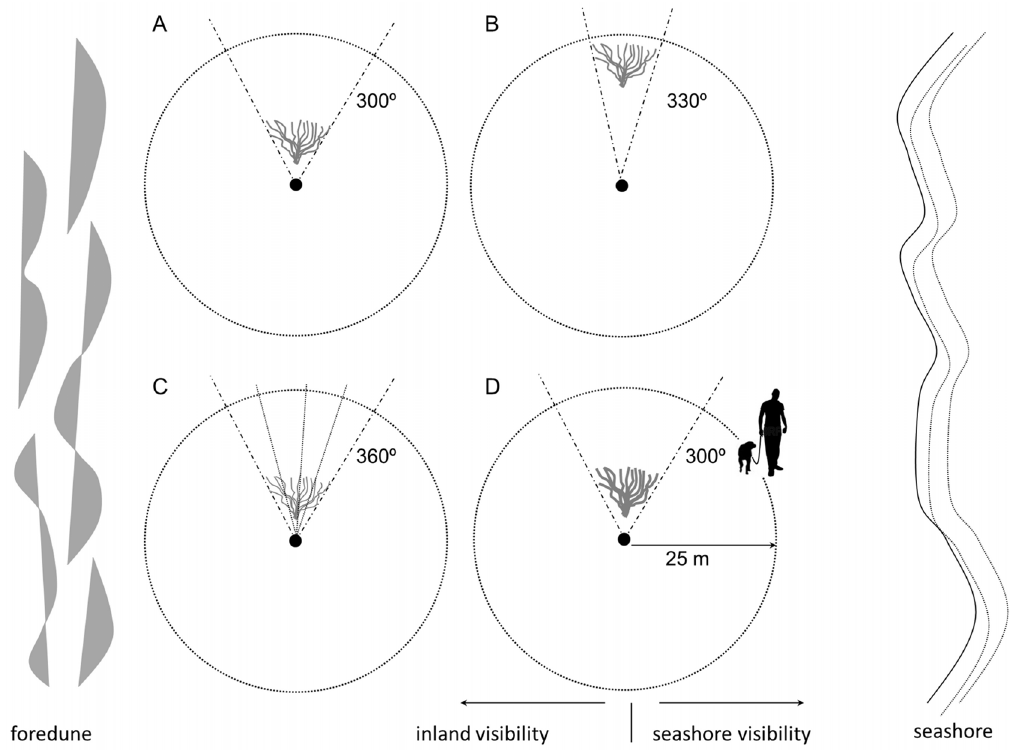
Figure 3. Experimental design to record visibility from Kentish Plovers’ nests. Black dots show the location of Kentish plovers’ nests. Circular dashed lines shows the perimeter of the circle (25 m radius) in which the visibility of both humans and dogs were recorded. Inland and seashore visibility were recorded separately by dividing the circle in two 180 u sectors parallel to the seashore. The figure illustrates four different situations in which vegetation may obstruct plovers’ view: a plant close to the nest (A) obstructs more (60 u of view occluded) than the same plant farther from the nest (B) (30 u of view occluded). In addition, a plant located at the same distance from the nest may allow the visibility through it (C) or may obstruct totally the visibility (D) depending on the permeability of the foliage